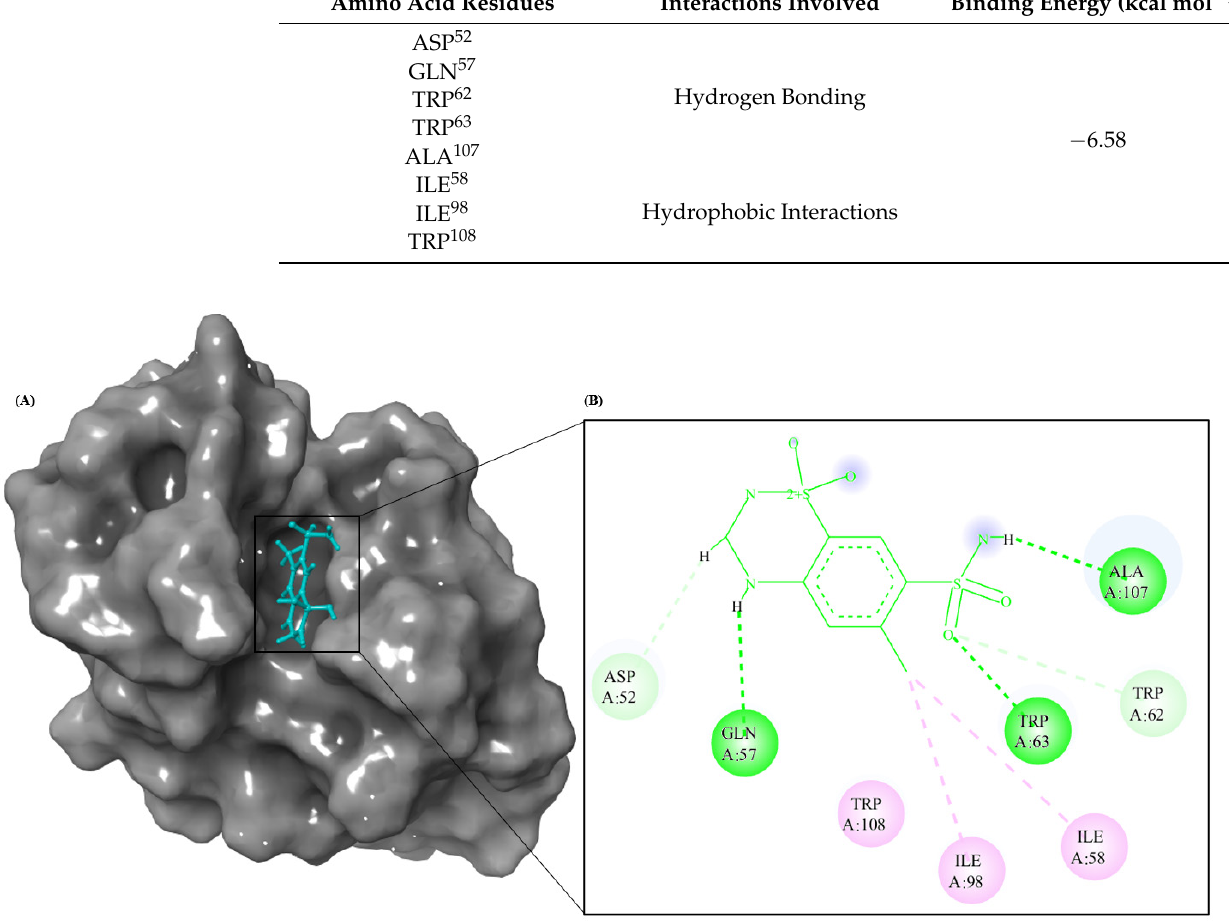
Figure 9. HEWL − CTZ interaction analysis using docking method. ( A ) Panoramic view of the HEWL–CTZ binding mode. ( B ) Interaction profile of HEWL and CTZ. The binding residues in each site were visualized using discovery studio. In the 2D diagram, green color represents hydrogen bonds, pink color represents hydrophobic interactions, and orange color represent electrostatic interactions. Table 2. Amino acid residues of HEWL that interact with CTZ.